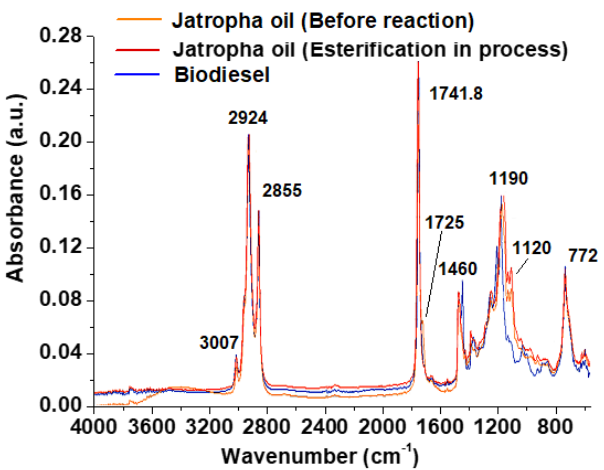
Figure 9. FTIR spectra of the obtained biodiesel, the oil obtained during the transesterification procedure and the JCO procedure.